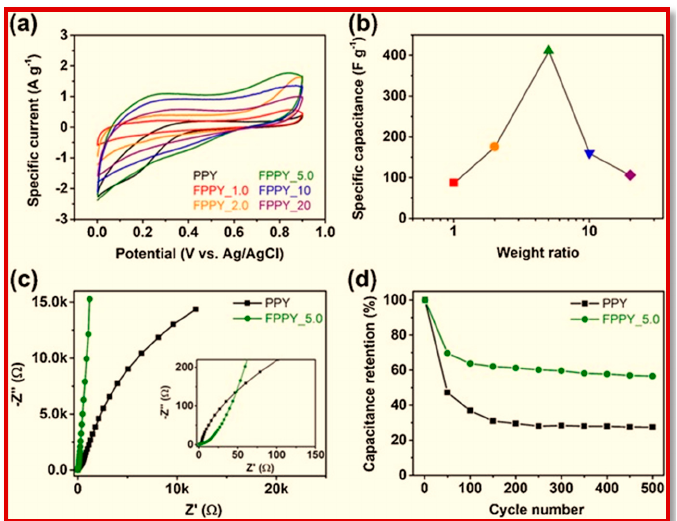
Figure 10. ( a ) CV curves for the series of FPPY hybrid nanomaterials, obtained at a scan rate of 2 mVs − 1 and ( b ) a comparison of the specific capacitance of the FPPY as a function of the PY/FP ratio. ( c ) Nyquist plot and ( d ) cycle stability of PPY– and FPPY_5.0-based supercapacitors. The